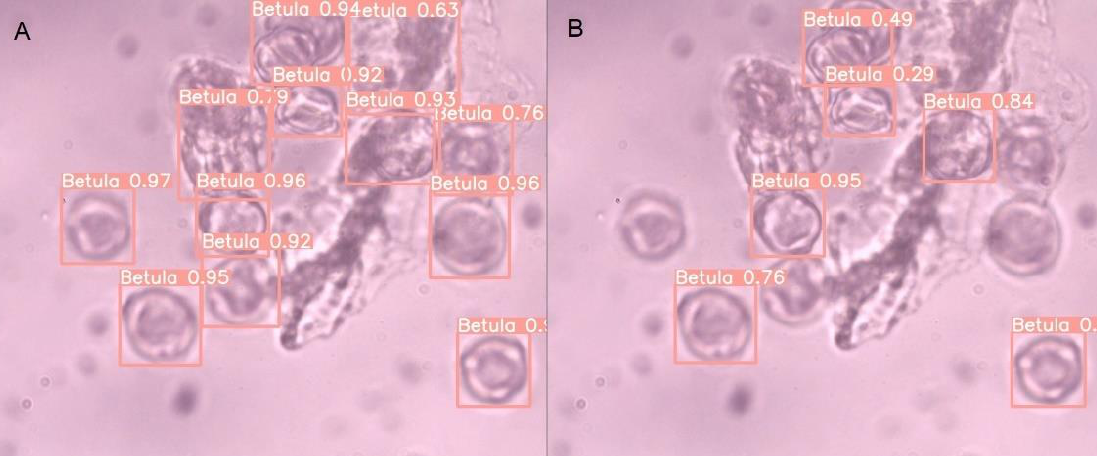
Figure 4. Sample image from the testMix dataset with predicted bounding boxes: ( A ) ModelAll (YOLOv5s) with Betula grains incorrectly detected as Corylus grain; ( B ) ModelVisAll (YOLOv5s) with a correctly detected Betula grain.